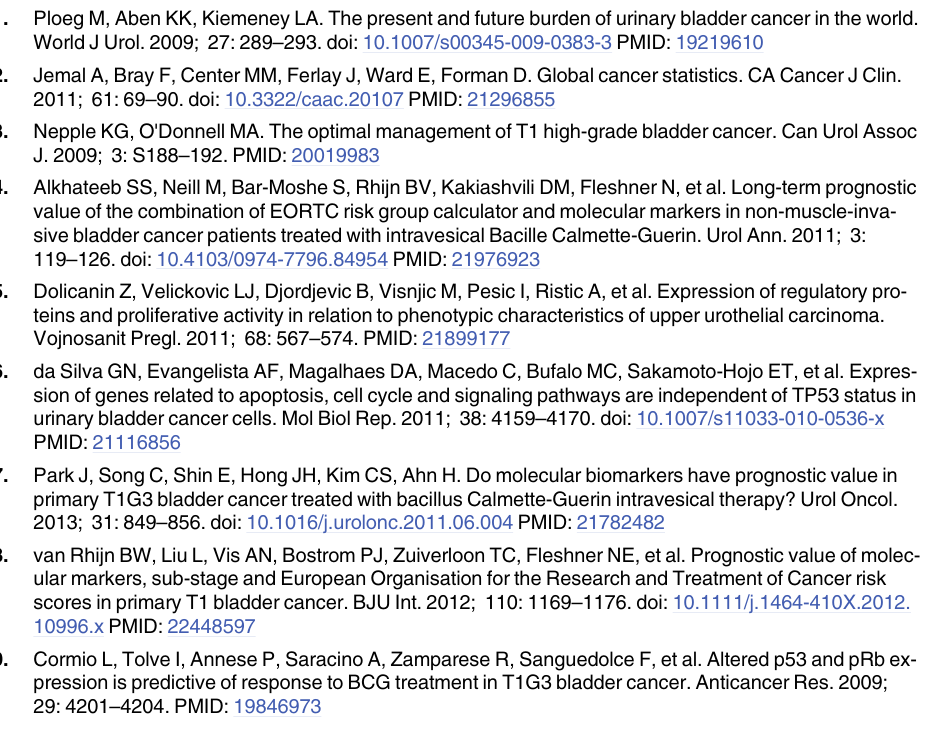
S1 Fig. Results from cumulative meta-analysis of the association between p53 expression and RFS (A) or PFS